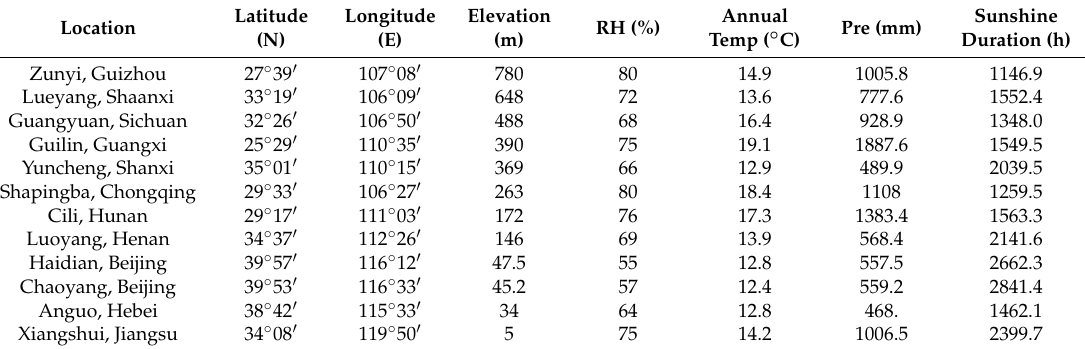
Table 1. Collection locations of E. ulmoides fruit and associated environmental